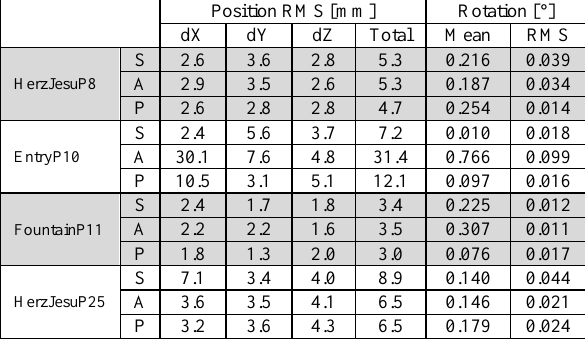
Table 1. Deviation between exterior orientation ground